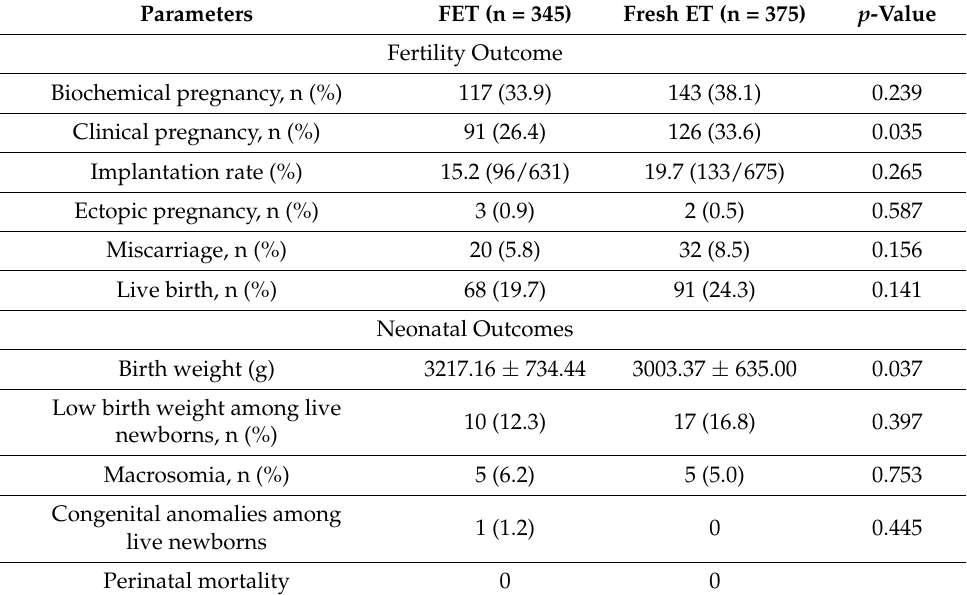
Table 3. Fertility outcomes and neonatal outcomes after FET cycles and fresh ET